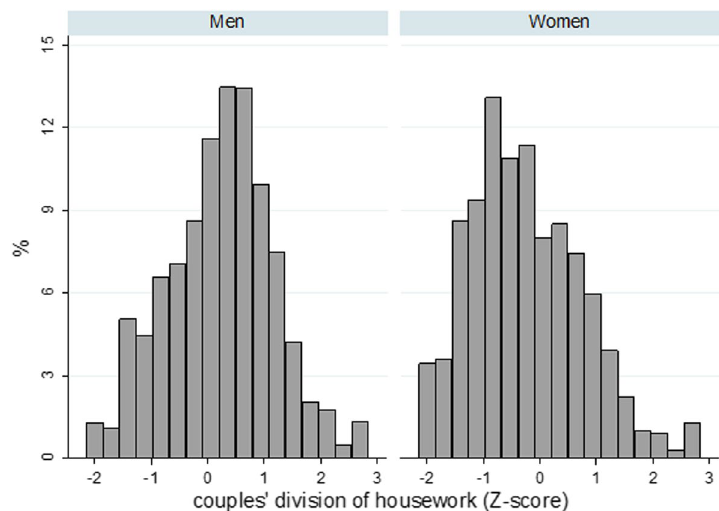
Fig. 1 Symmetry in the division of household tasks according to respondent’s gender (8 items). Higher values, more symmetry